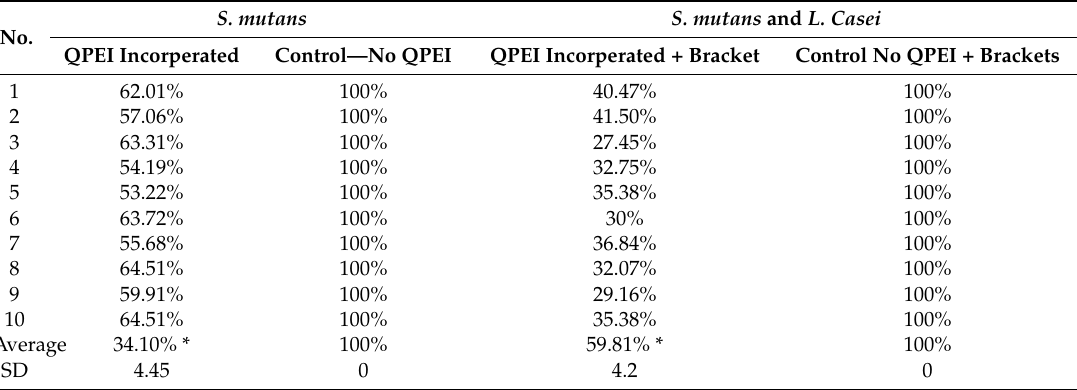
Figure 2. Neobond incorporating 1% QPEI (quaternary ammonium polyethylenimine) reduces bacterial biomass; * Statistically significant difference ( p < 0.05). Table 2. Percentage of decrease in biomass for the test groups: QPEI incorporated vs. control and QPEI incorporated + bracket vs.